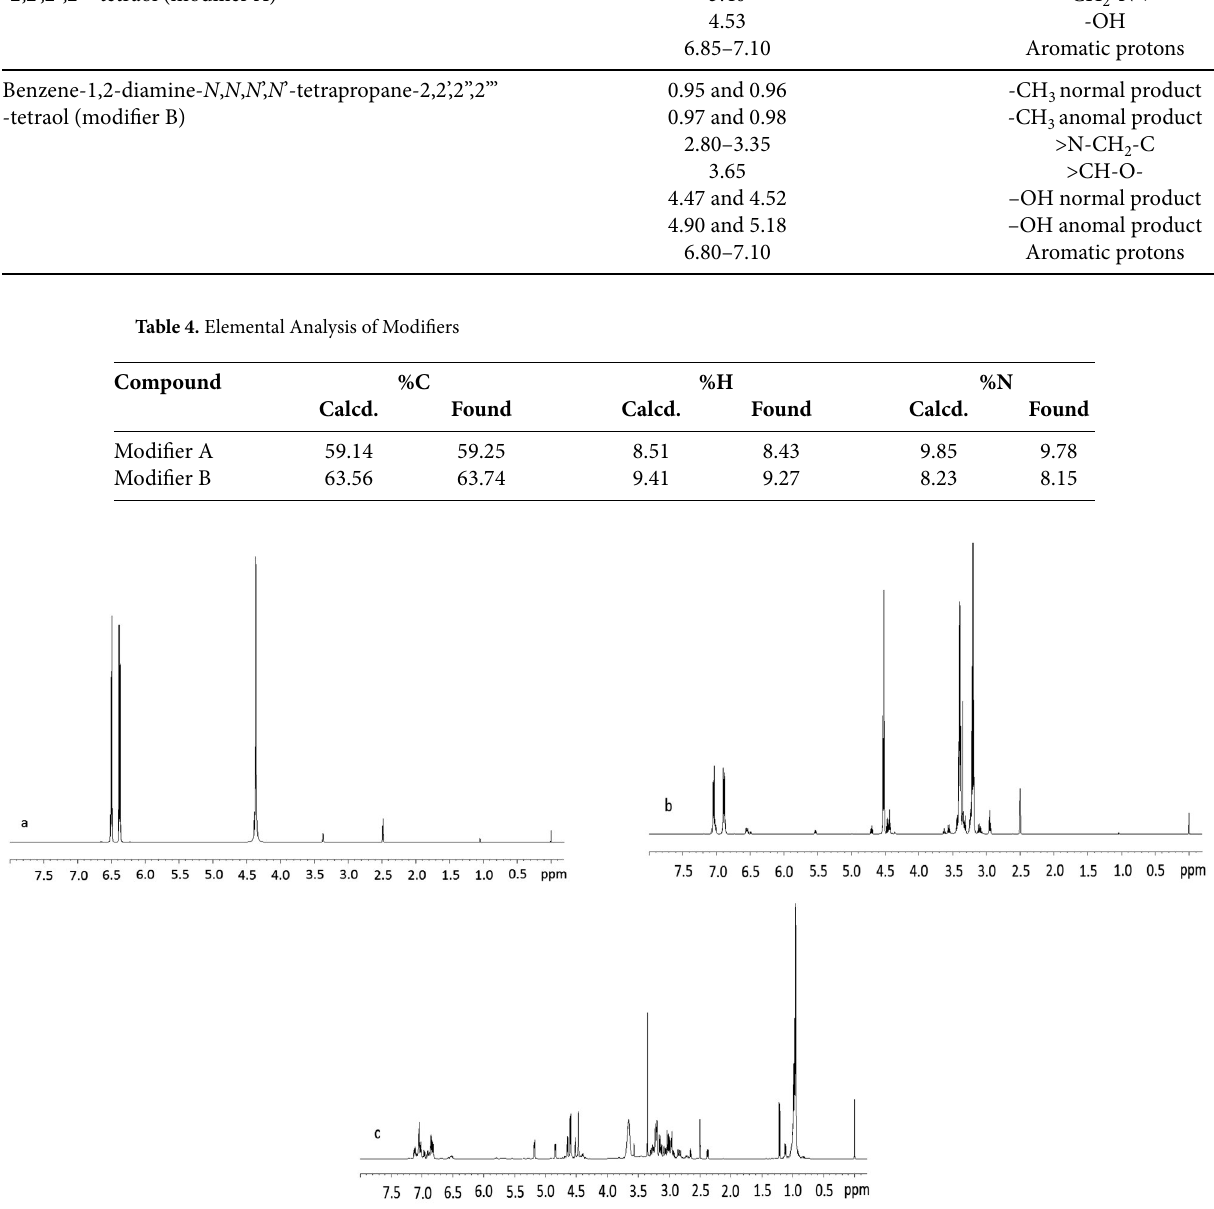
Figure 2. 1 H NMR spectra of phenylene-1,2-diamine (a), benzene-1,2-diamine- N , N , N ’, N ’-tetraethane-2,2’,2’’,2’’’-tetraol (modifier A) (b), and ben- zene-1,2-diamine- N , N , N ’, N ’-tetrapropane-2,2’,2’’,2’’’-tetraol (modifier B) (c). (0.5 mol) of phtalic anhydride, 49.0 g (0.5 mol) of maleic anhydride, 41.0 g (0.43 mol) of diethylene glycol, 42–44 mL (0.57–0.60 mol) of propylene glycol (depending on the amount of amine-glycol modifier added), and the modifier itself up to 6.4 g (2.0 wt.-% with respect to the total mass